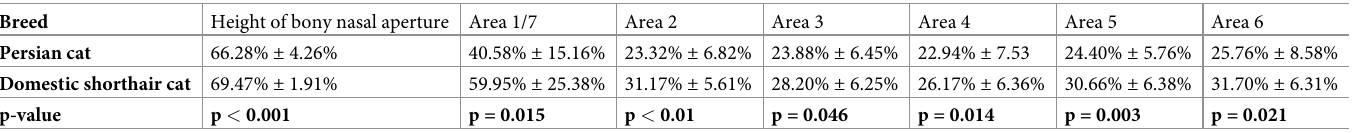
Table 2. Summary of the area comparison of the nasal airways of Persian and Domestic shorthair cats. Area 1/7: area of the nares in relation to area of the meatus nasopharyngeus; area 2: upper canine; area 3: palatine fissure; area 4: bony nasal aperture; area 5: second premolar; area 6: third premolar. Breed Height of bony nasal aperture Area